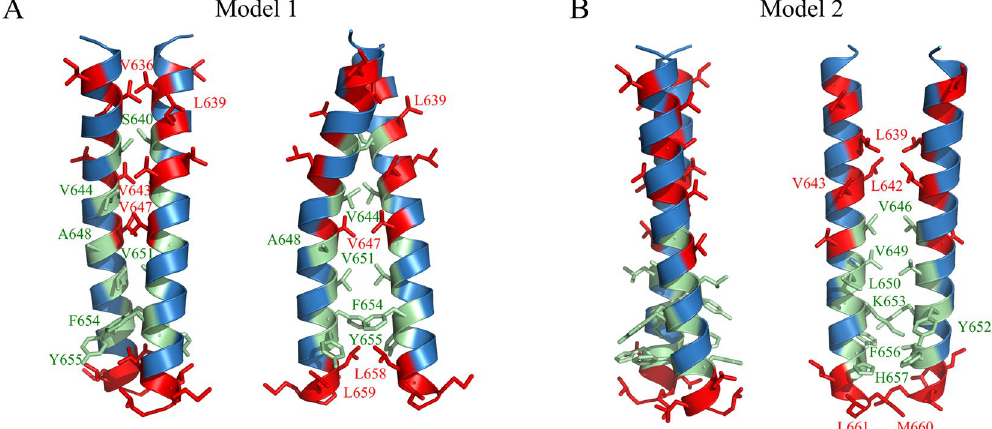
Figure 4. Two top-ranked dimeric conformations of TLR4-TMICL in DPC micelles out of 12 possible structures, generated by TMDOCK 33 . Residues, experiencing the maximal chemical shift perturbations upon the dimerization are shown in red. Other residues on the dimerization interface are shown in pale green and assigned. Model 1 ( A ) was selected as the most probable conformation of TLR4-TMICL dimer, while the Model 2 ( B ) was rejected due to the inconsistency with NMR